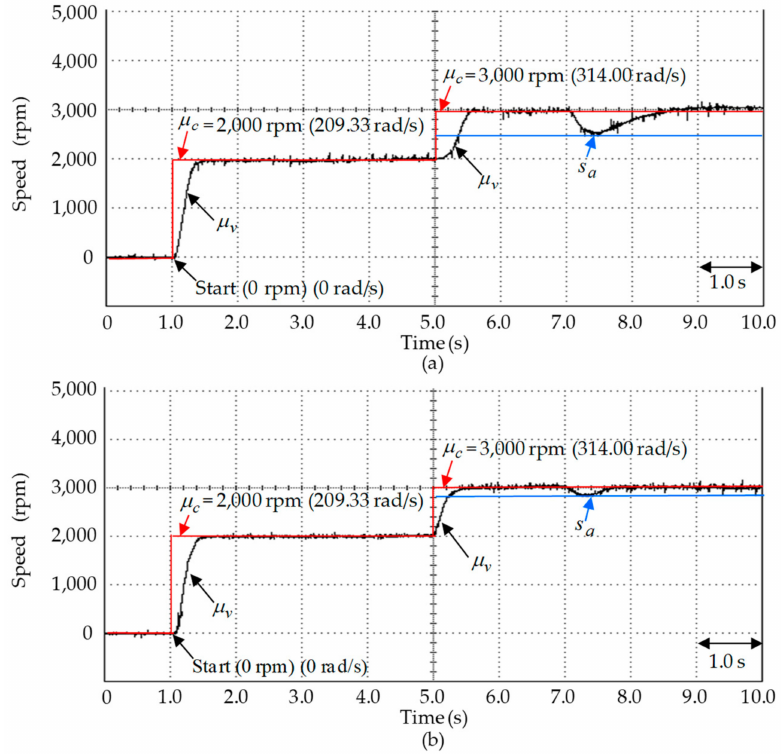
Figure 13. Two speed-regulated responses when adding load torque via experimental results of test JC by adopting the controllers: ( a ) TA; ( b )